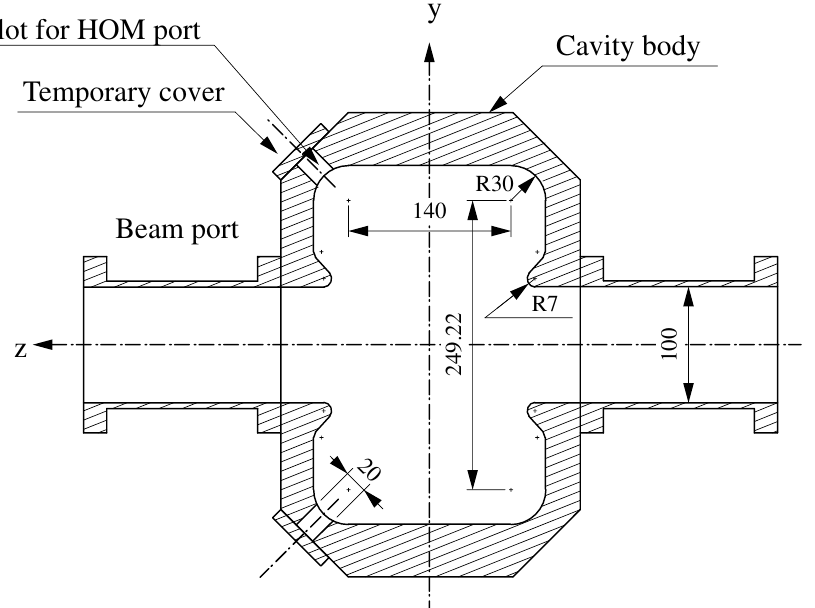
FIG. 7. Cross section of a low-power model of the 714-MHz damped cavity, where HOM ports have been removed and shorted. There are two other slots for HOM ports, which are located on the other ( z < 0 ) side with 90 (cid:21) rotation. Units: mm.